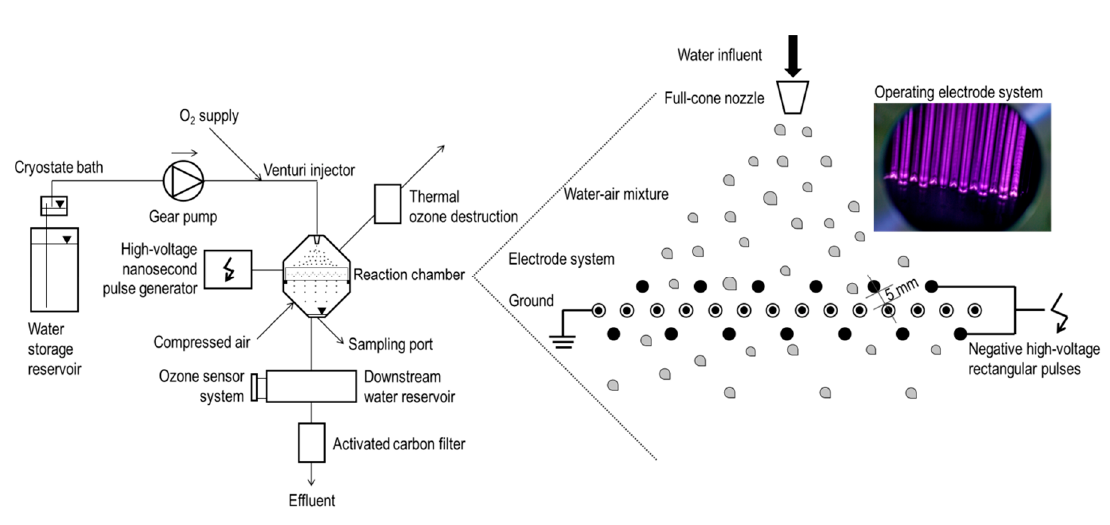
Figure 1. Set-up of the lab-scale water treatment plant.